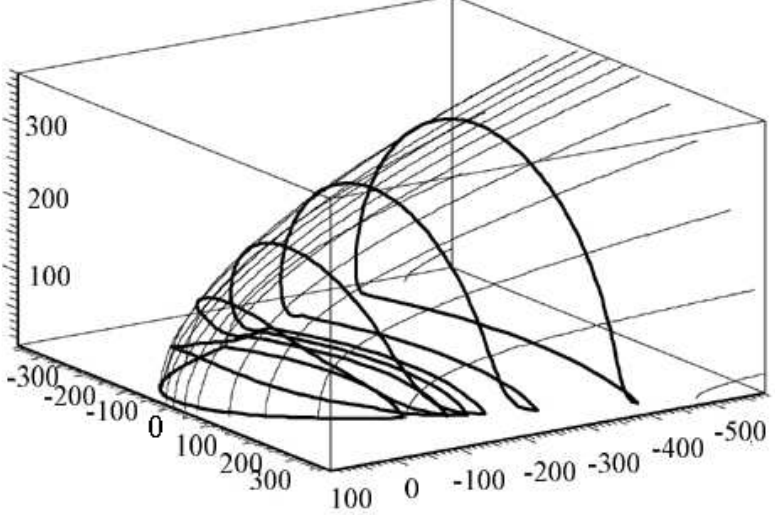
Fig. 3. The tail current system is shown. In the equatorial tail, the current flows from dusk to dawn. This current is closed by the northern and southern magnetopause currents. The current lines are shown by heavy curves. Thin curves mark the magnetic field lines lying on the magnetopause. Parameters of the tail current system used in the calculations are R ss = 100 R J and R 2 = 65 R J . Under condition of the absence of the component of the tail current system magnetic field normal to the magnetopause, the closure currents from the inner part of the tail current should go to the dayside magnetopause. This is a consequence of very high conductivity of the solar wind plasma which preserves penetration of the magnetic field outside the magnetosphere.